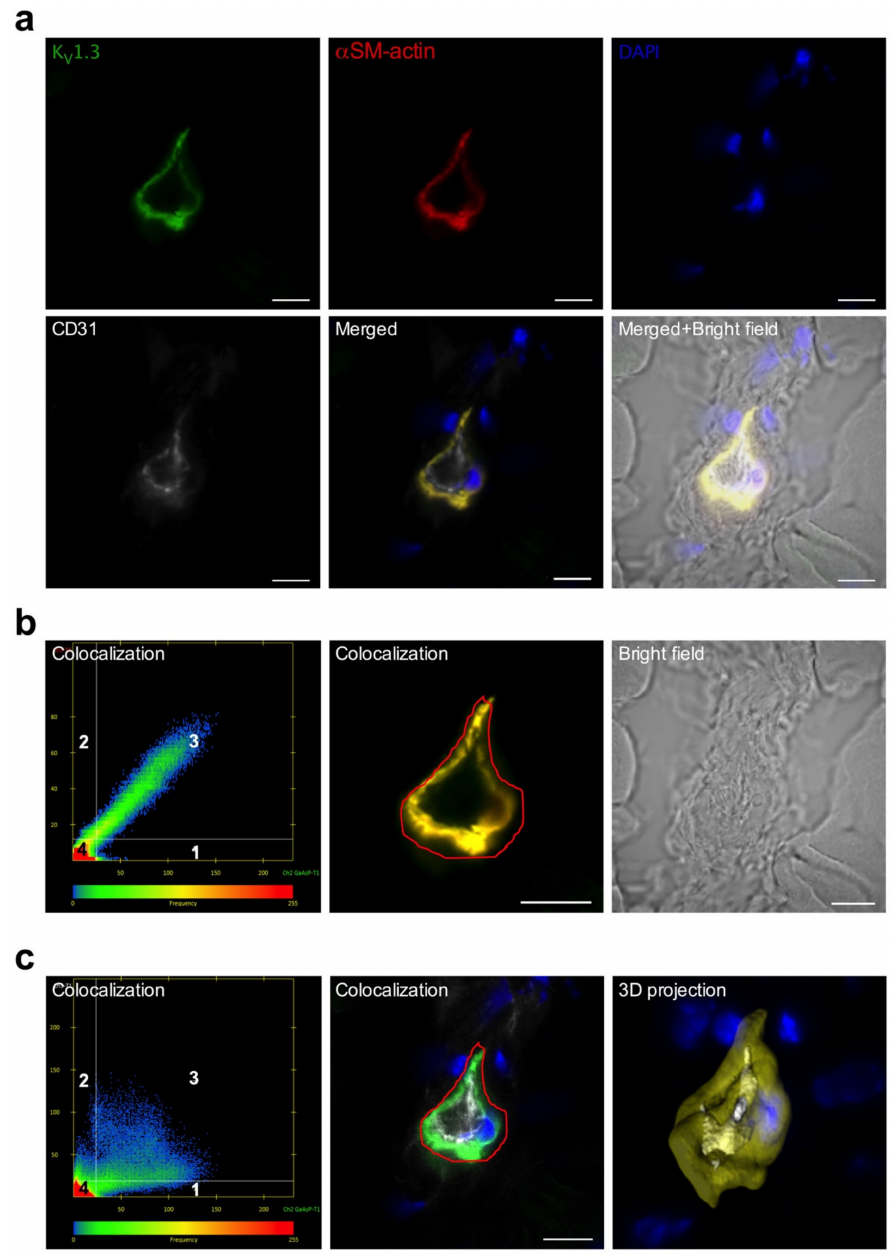
Figure 3. Localization of K V 1.3 in ECs and SMCs of murine collateral arteries. ( a ) Representative confocal immunofluorescence images of transversal sections of collateral arteries isolated 3 h after induction of arteriogenesis. Tissue sections were stained with an antibody against K V 1.3 (green), together with the SMC marker α SM-actin (red), the EC marker CD31 (grey), and DAPI (blue); ( b , c ) Scatterplots showing the colocalization analysis. Quadrant 4 (left lower left panel) represents pixels that have low intensity levels in both channels, green and red ( b ) or green and grey ( c ), and these pixels are referred to as background and are not taken into consideration for colocalization analysis. Quadrant 1 represent pixels that have high green intensities and low red intensities and Quadrant 2 represents pixels that have high red intensities and low green intensities. Quadrant 3 represents pixels with high intensity levels in both green and red in ( b ) and green and grey in ( c ). These pixels are considered to be colocalized. Scale bar 20 µ m. Bright field image is also displayed. ( c ) 3D projection surface rendering is showing the localization of the K V 1.3 with the labelling CD 31 and α SM-actin on the panel ( c ) right lower